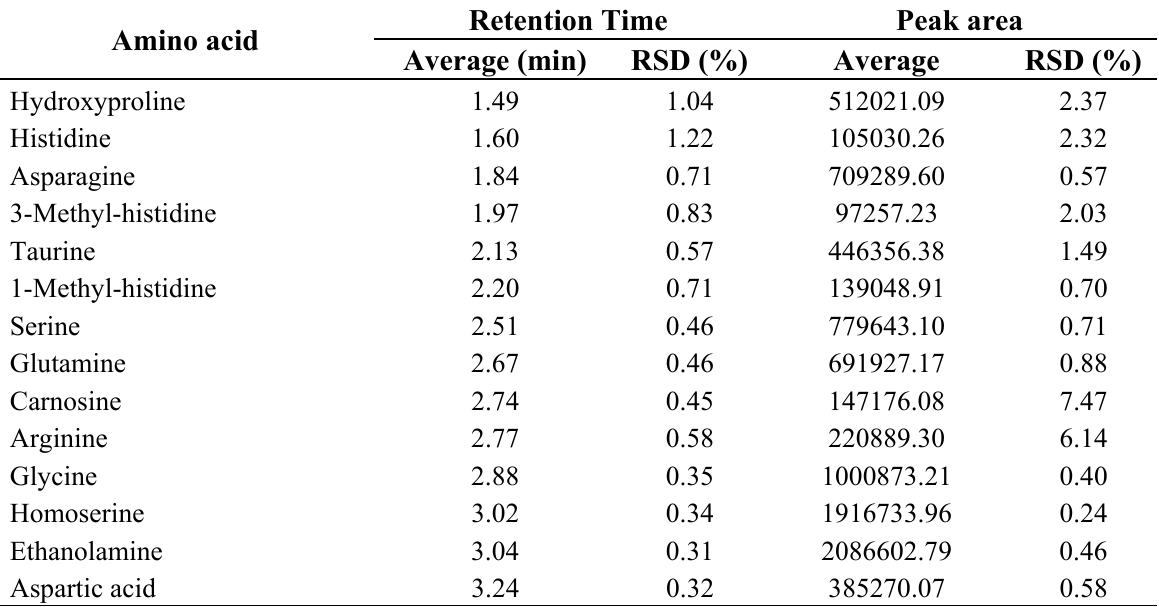
) and peak area relative standard deviation Table 2. Representative retention time (R t (RSD) values obtained from the UPLC-ESI-MS/MS analysis of AQC-derivatized amino and respective RSD values calculated in standard solutions (n = 30). acids. Average R t Average peak area and respective RSD values calculated in the standard solution 2.5 × 10 − 5 M (n =